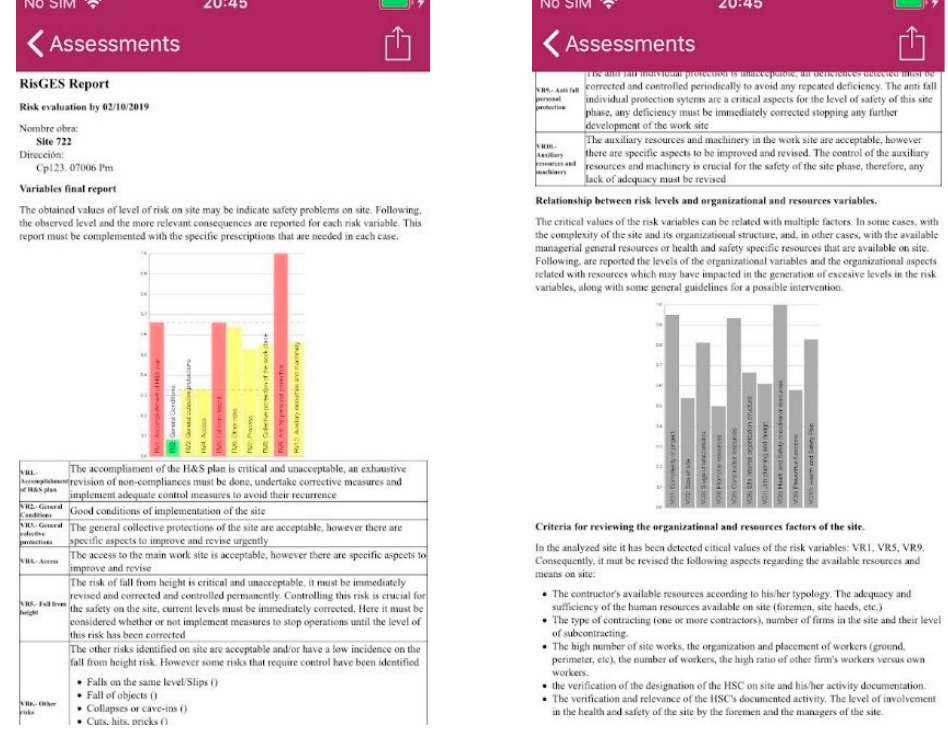
Figure 4. Examples of the screen capture of site inspection and recommendation reports. Source: App screenshots. (See Appendix C to read the complete sample reports).